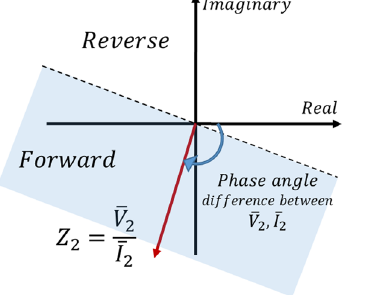
Fig. 10 Fault identification